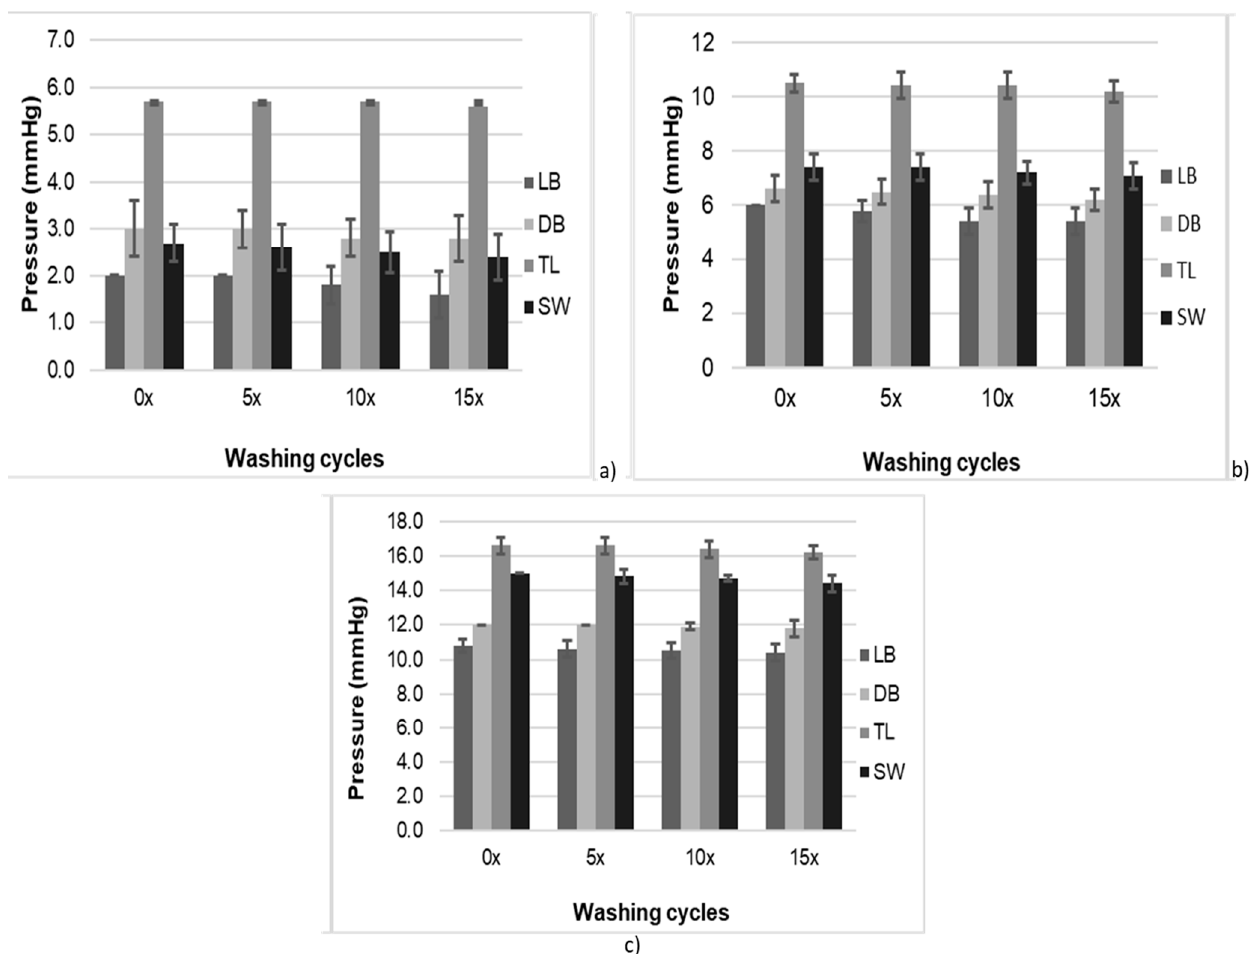
Figure 4. Pressure exerted by the 10% stretched fabrics ( a ), 20% stretched fabrics ( b ) and 30% stretched fabrics ( c ) on the tube after 5, 10 and 15 washing cycles.